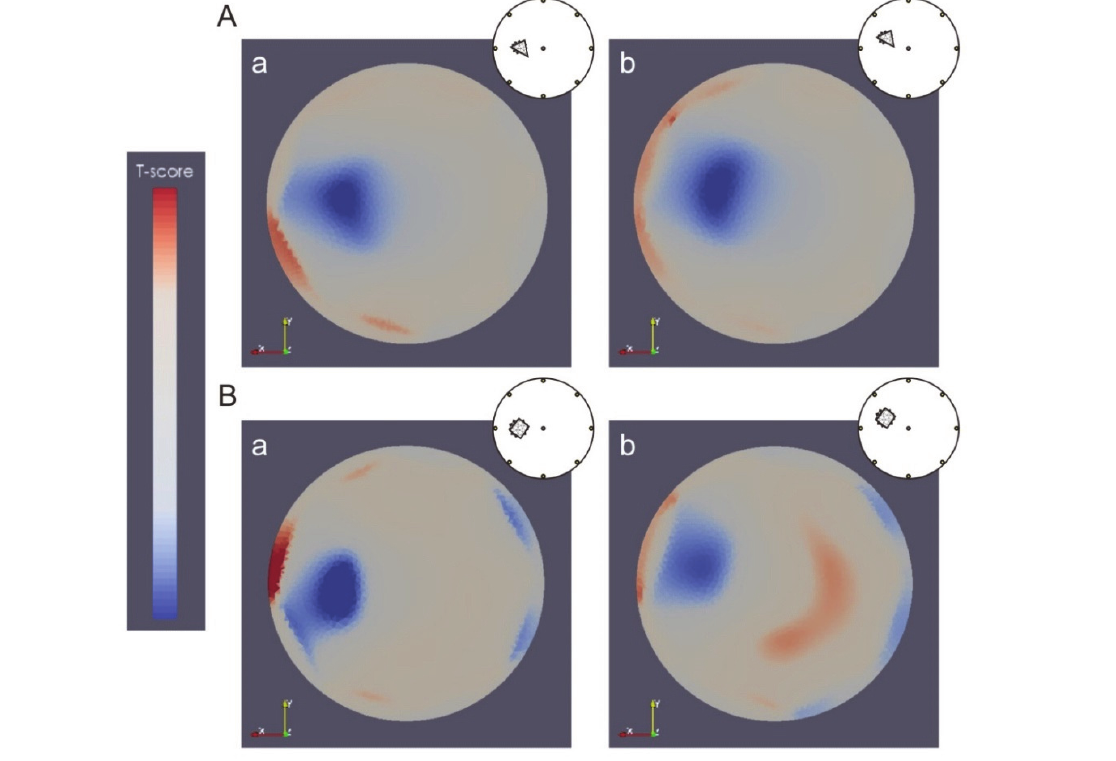
Fig. 6 Image reconstruction in (Aa and Ba) t-EIT and (Ab and Bb) f-EIT for an irregular triangular and square shaped potato object placed in the measurement chamber filled with electrolyte using the polar-offset configuration (Fig. 2b) and the customised algorithm (top view). The real position is shown in the inserts at the top right. Images for a (A) triangular object and (B) square shaped object in two alternative positions: 2.5 mm radial centre-to-centre distance between the phantom and the chamber, (a) angle of 135° and (b) angle of 112.5°. The colour scale is in arbitrary units (from -1 in blue, to +1 in red) representing the